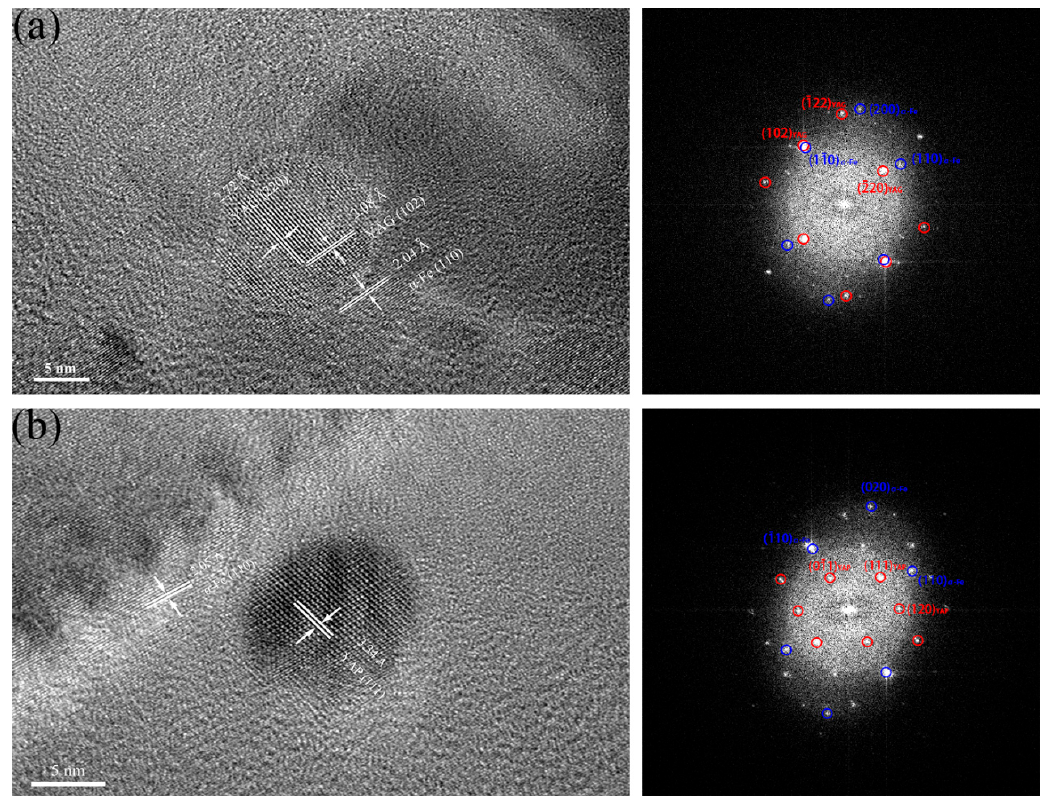
Figure 8. HRTEM micrographs and corresponding FFT images of Y-Al-O oxides in: ( a ) 16Cr-0.3Zr ODS steel; and ( b ) 16Cr-0.6Zr ODS steel.